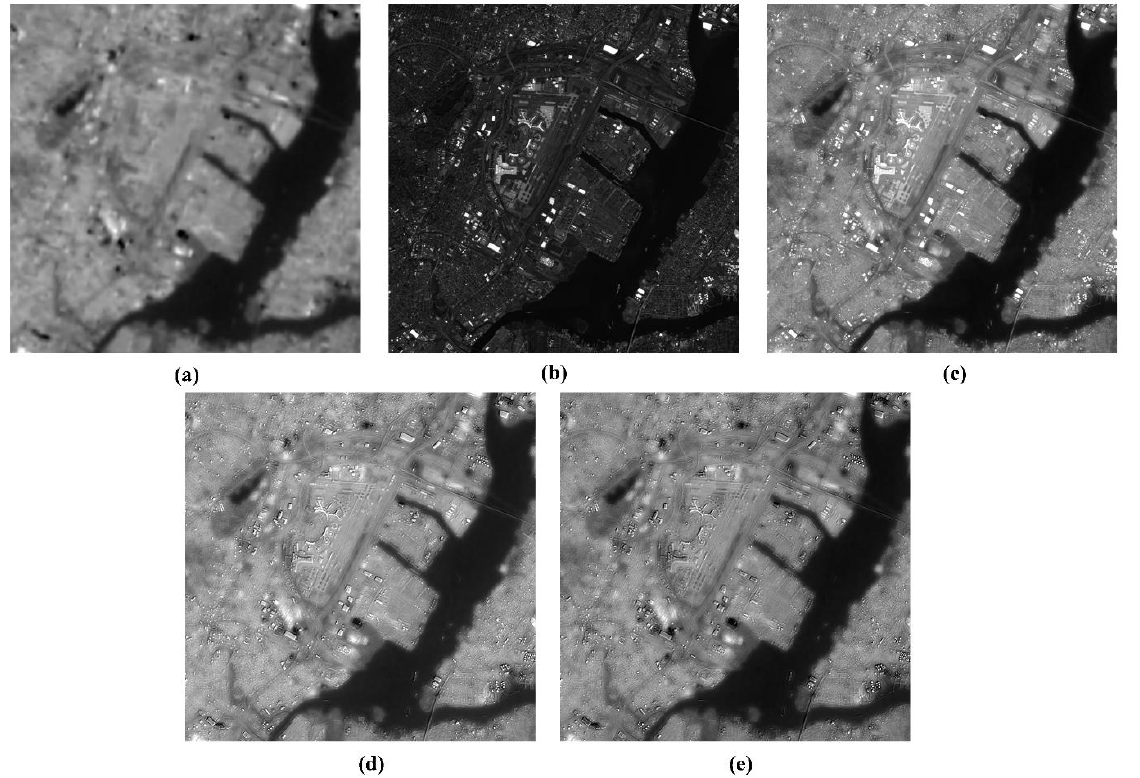
Figure 12. Experimental results of different fusion algorithms on Landsat9 data: ( a ) Landsat9 thermal infrared band image resolution of 100 m; ( b ) Landsat9 panchromatic band image resolution of 15 m; ( c ) fusion results of OSF algorithm; ( d ) fusion results of SRT algorithm; ( e ) experimental results of our proposed algorithm.